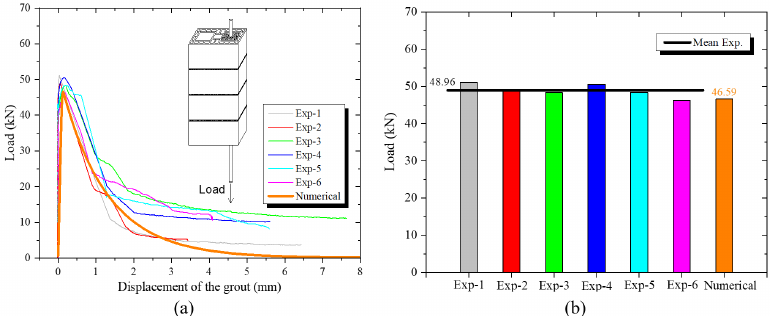
Figure 13. Validation of numerical results of the ClG14S16 series of pull-out tests: (a) force vs displacement diagrams and (b) mean maximum load.